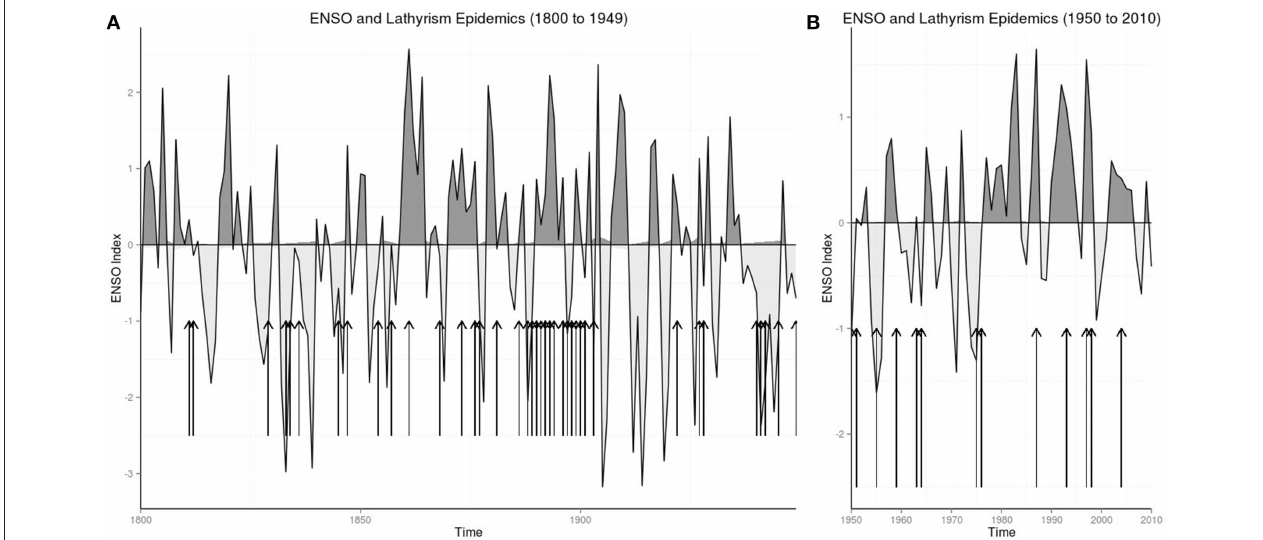
FIGURE 1 | Cycle plots of ENSO mapping lathyrism